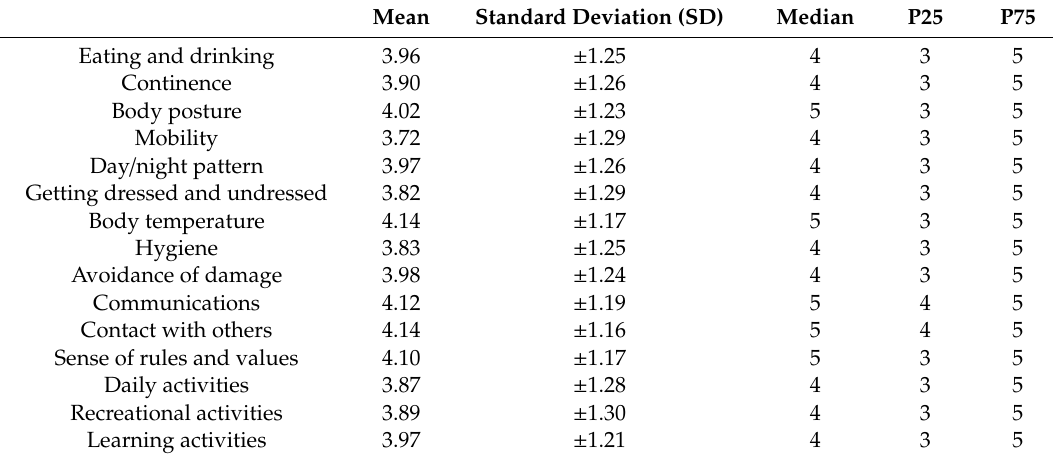
Table 2. HF patients’ level of dependency for each of the Care Dependency Scale (CDS) categories.